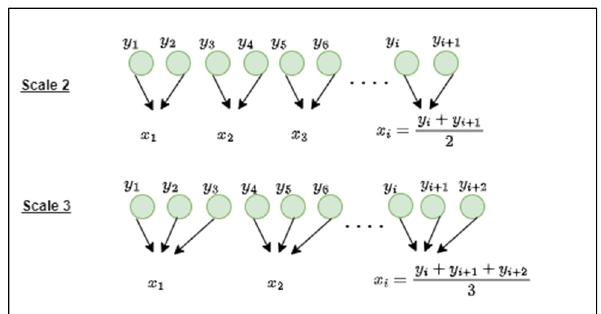
Figure 5. Illustration of the coarse-grained